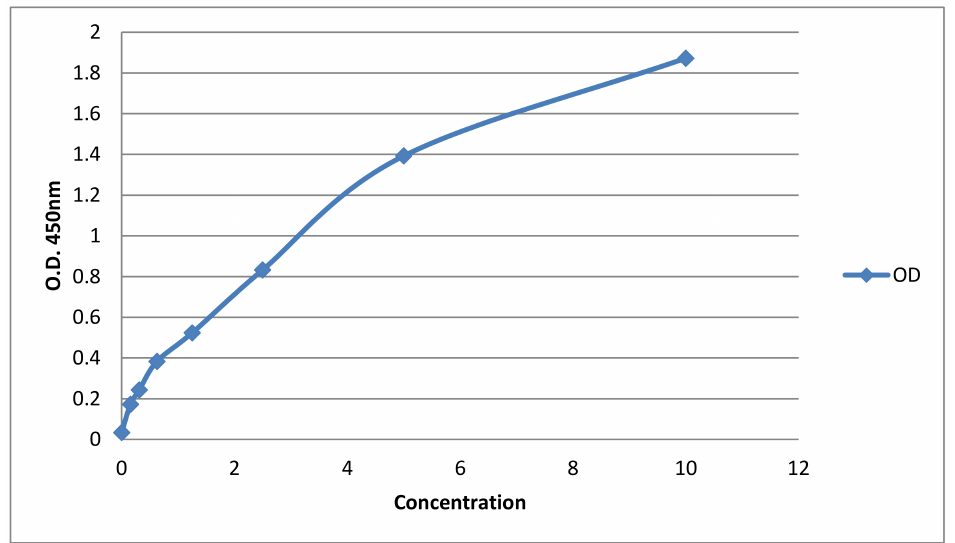
Figure 4. Standard curve: Results of a typical standard run of calprotectin ELISA kit is shown below. The X -axis shows the concentration of calprotectin, and the y-axis shows the O.D